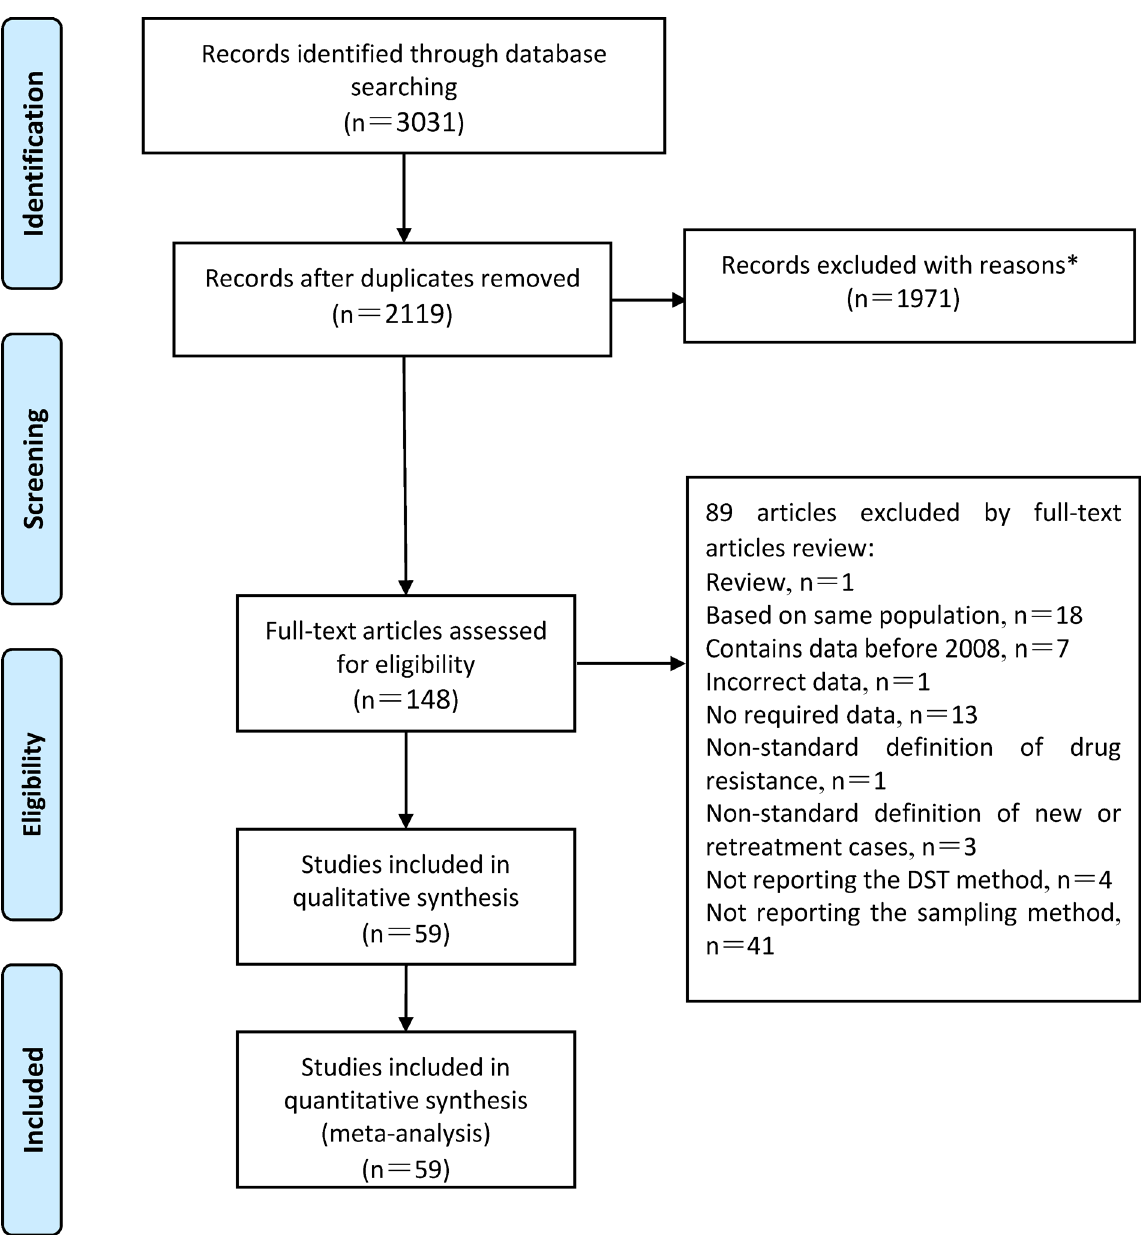
Fig 1. Flow chart depicting the study selection process. * The reasons including irrelevant topic, articles from Chinese non-scientific-key journals, review, insufficient data.